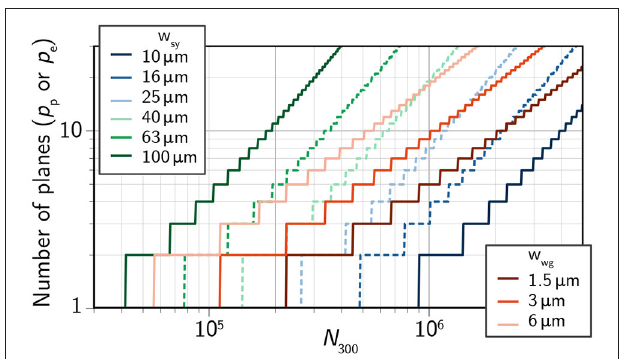
FIGURE 5 | Number of planes of active synaptic circuits ( p e ) and passive photonic waveguides ( p e ) required to maintain a path length of 2.5 as a function of the number of neurons on a 300-mm wafer ( N 300